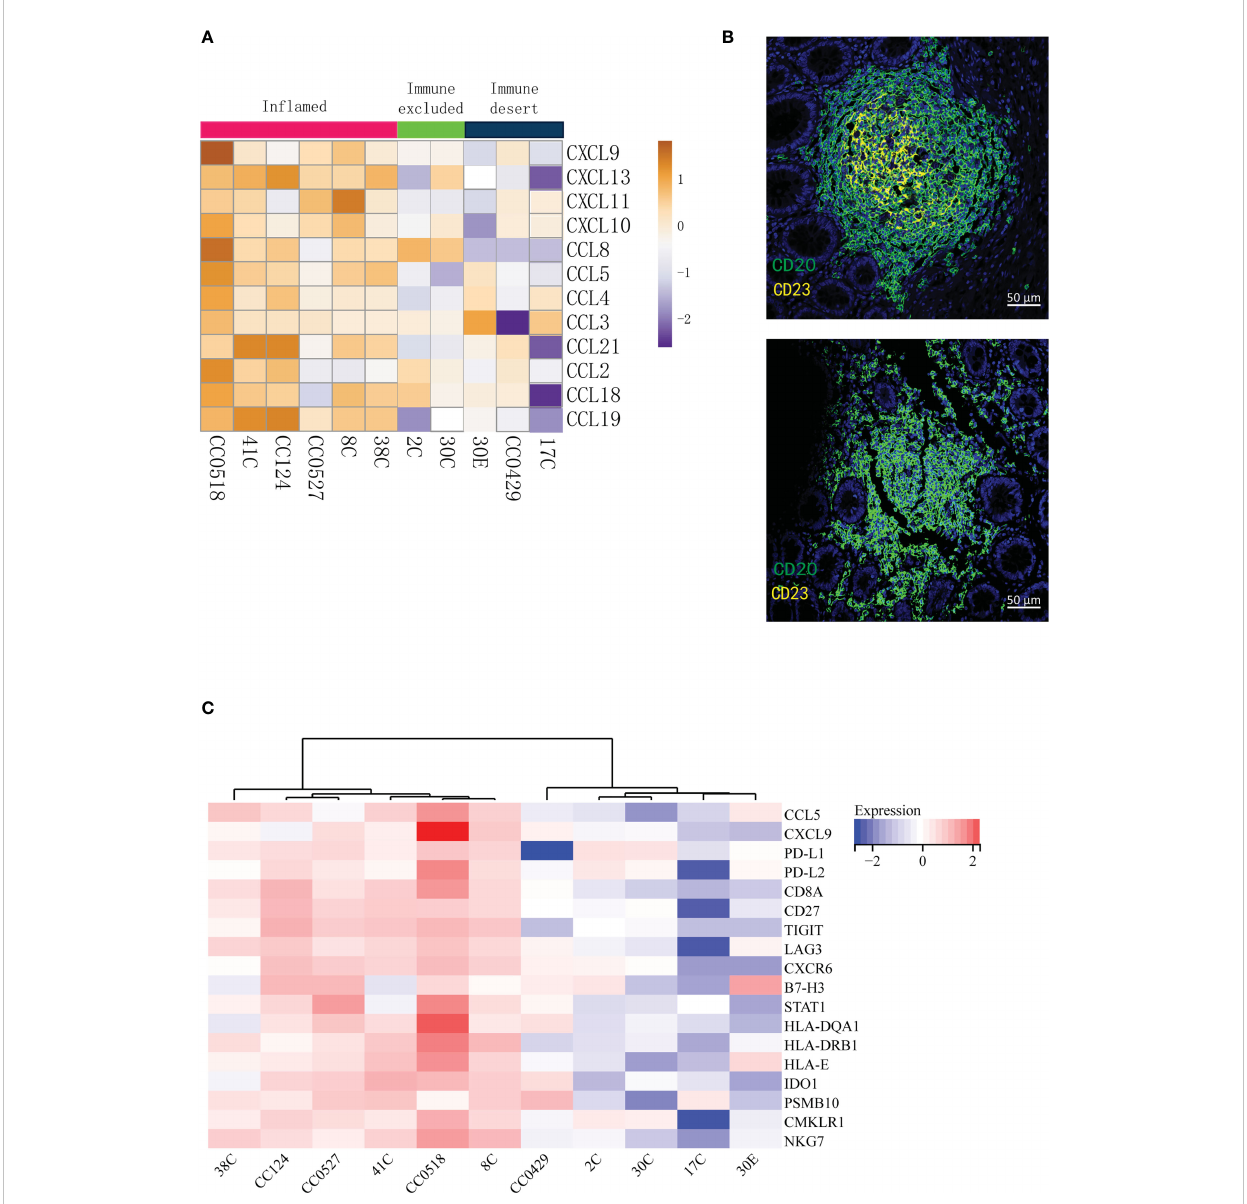
FIGURE 3 The tumor immune signatures are associated with the in fi ltration of distinct populations of immune cells and with the status of tertiary lymphoid structures. (A) Analysis of the 12-chemokine transcriptional expression suggests that the presence of tertiary lymphoid structures varies in different tumor immune signatures. (B) Multiplex IF of CD20 and CD23 shows that while mature TLSs (top) are found in the tumors of immune excluded and in fl amed, immature TLSs (bottom) are related to the desert tumors. (C) The GEPs cannot distinguish immune excluded and immune desert tumors. The 18-gene T in fl amed gene expression pro fi les (GEPs) are applied to the transcription pro fi les of 11 tumors; the cluster of GEPs is presented as a heat